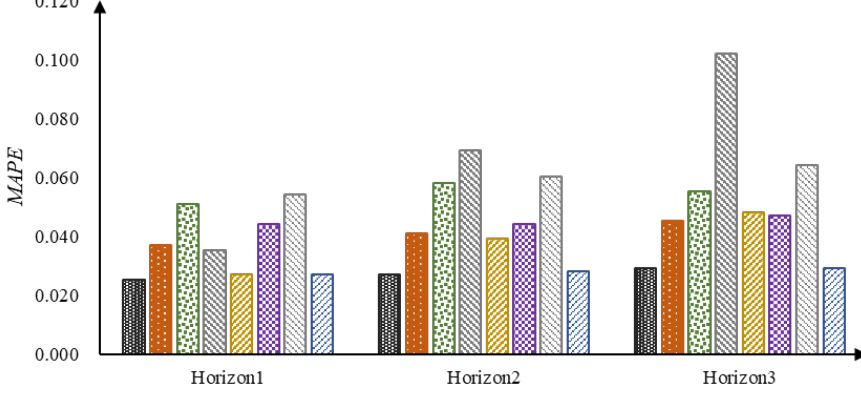
Figure 9. MAPE of each model in multi-step-ahead forecasting in discussion.